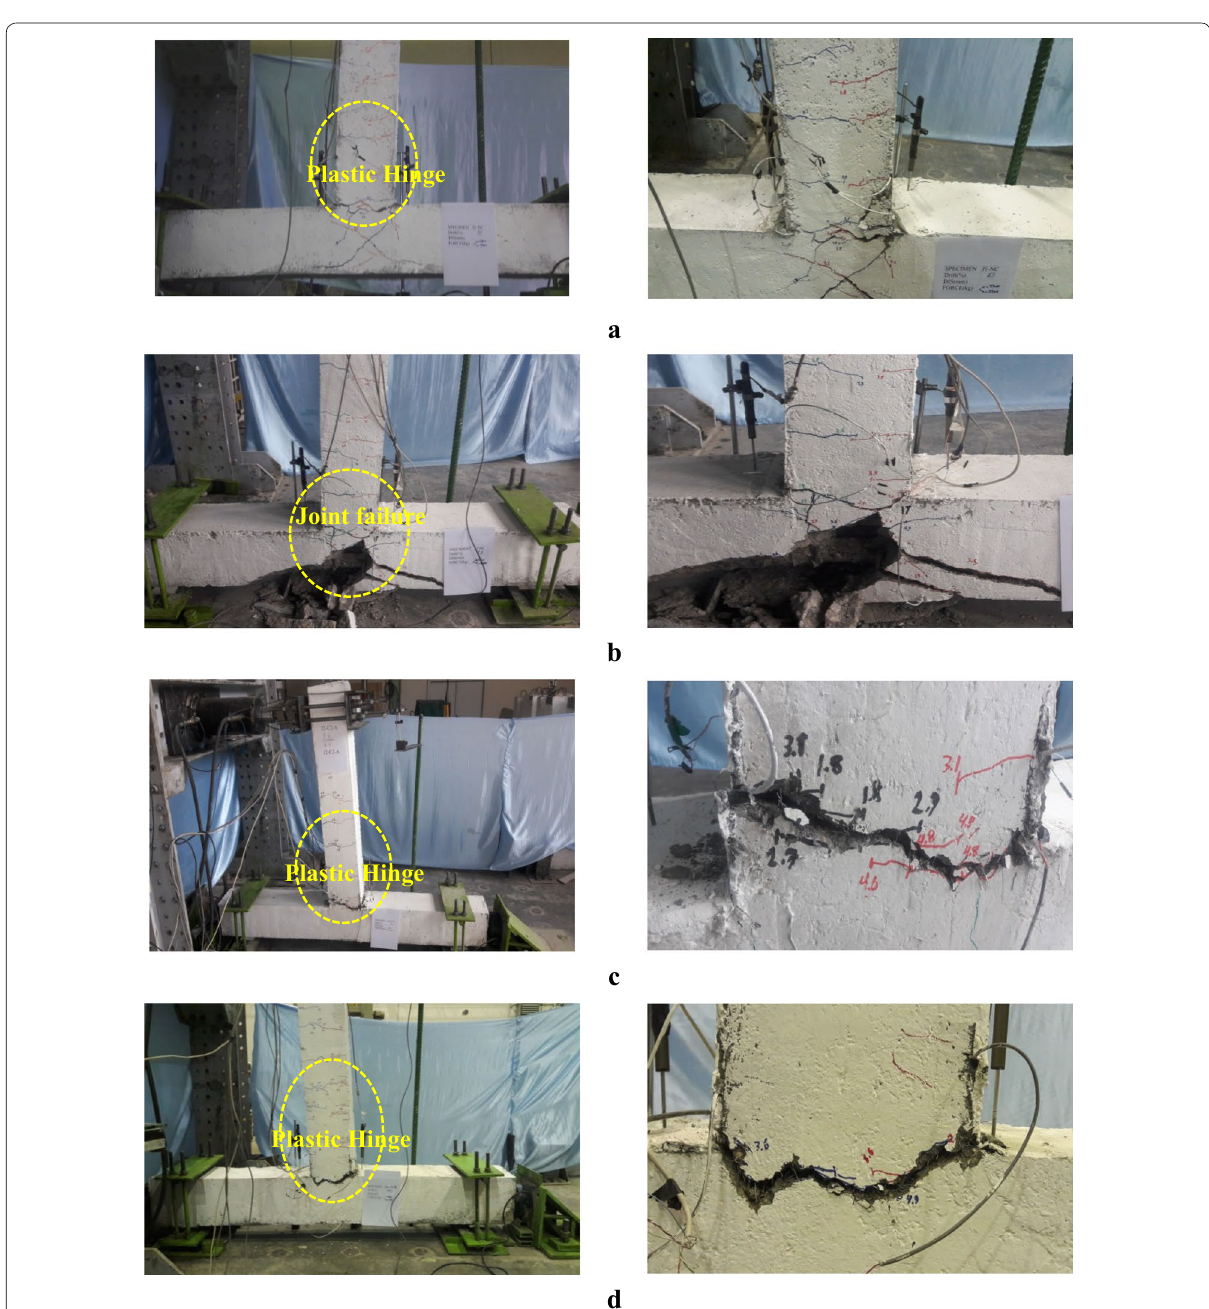
Fig. 17 Cracking pattern and failure mode in drift of 6%: a C1 specimen; b C2 specimen; c SC2-A specimen; d SC2-B